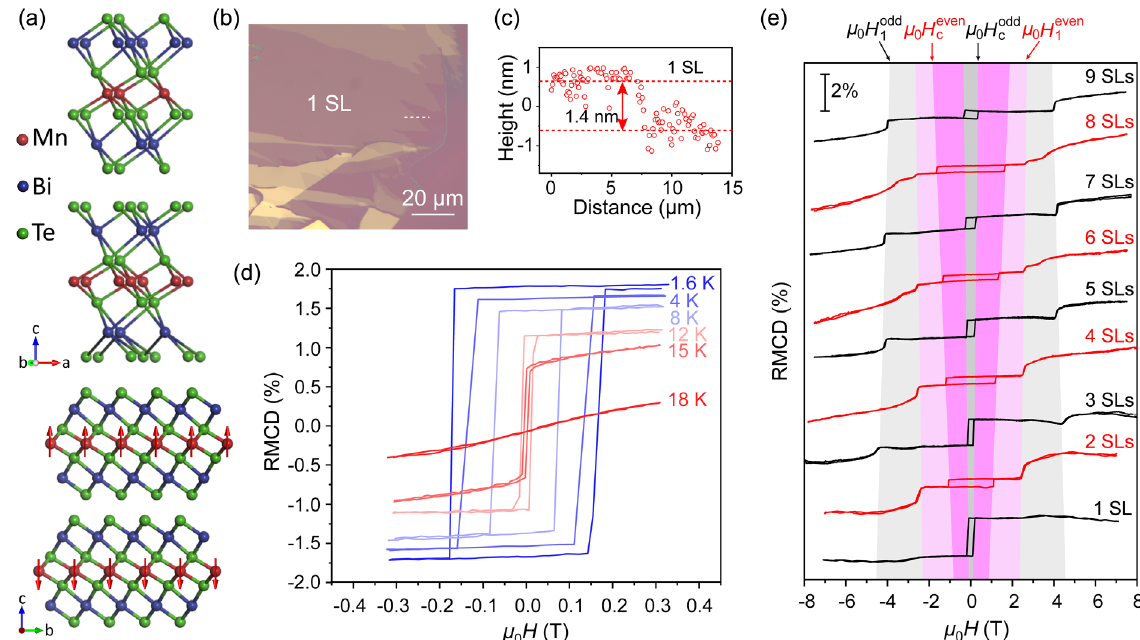
FIG. 1. Crystal structure and RMCD measurements of 1-SL to 9-SL MnBi 2 Te 4 flakes. (a) Crystal structure of MnBi 2 Te 4 . The septuple atomic layers are stacked through vdW force. The arrows on the Mn atoms denote the magnetic moment of each Mn ion. Without an external magnetic field, the neighboring ferromagnetic SLs couple antiferromagnetically, with an out-of-plane orientation. (b) Typical optical image of a 1-SL MnBi 2 Te 4 on the gold substrate. (c) Height line profile of the single-SL MnBi 2 Te 4 , along with the white dashed line in panel (b). The step height is 1.4 nm, consistent with the thickness of 1-SL MnBi 2 Te 4 . (d) Temperature-dependent RMCD measurements of the 1-SL MnBi 2 Te 4 . (e) RMCD measurements of MnBi 2 Te 4 flakes (from 1 SL to 9 SLs) at 1.6 K. The shaded areas highlight the thickness dependence of the low-field spin-flip and spin-flop phase transitions in odd- N and even- N SL samples. Note that the layer-dependent measurements are performed on the freshly exfoliated flake without PMMA